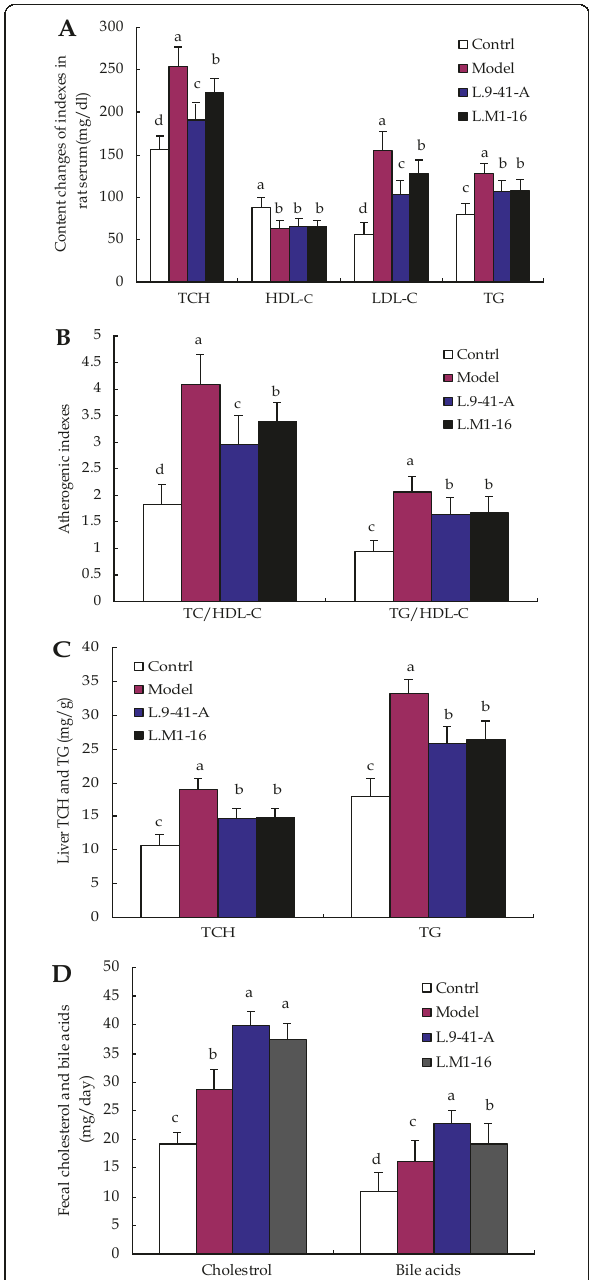
Figure 1 Effects of the two LAB strains on lipid metabolism in rats fed a high-cholesterol diet . A: Serum TCH, HDL-C, LDL-C and TG contents; B: Atherogenic indexes of the rats; C: Liver TCH and TG contents of the rats; D: Fecal total cholesterol and bile acid content. The data are shown as the mean ± standard deviation (n = 10), a,b,c,d Mean values in each panel with different superscript letters differ significantly (p <